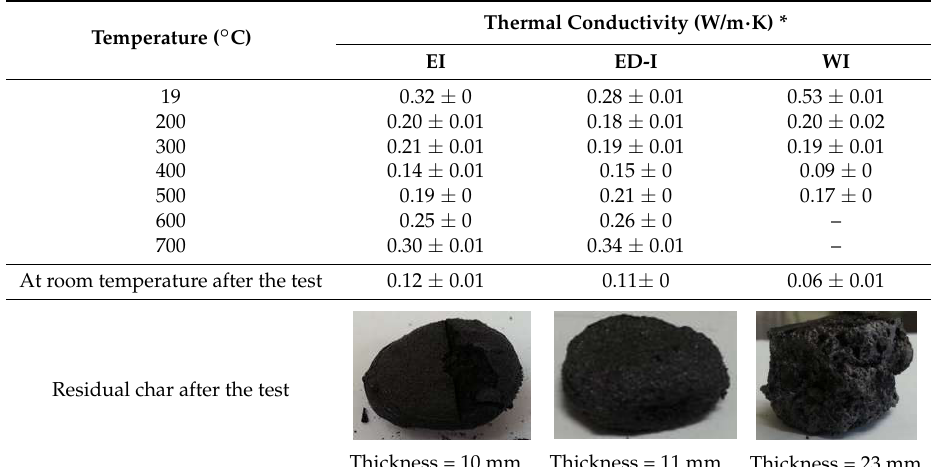
Table 4. Thermal conductivity values of the chars of intumescent coatings at different temperatures and images of residual chars obtained at the end of the test.